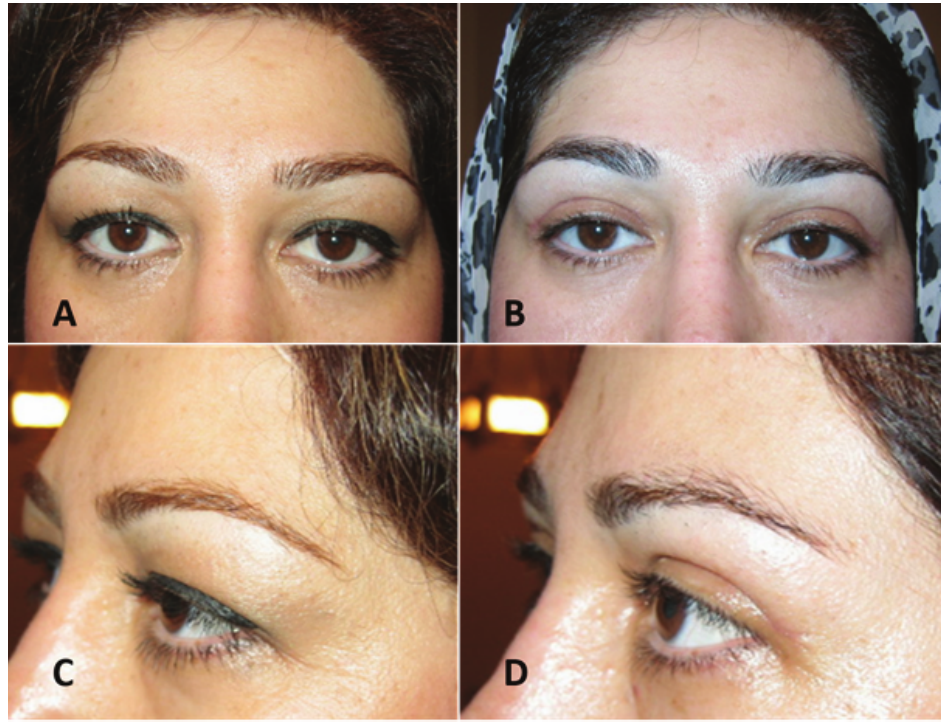
Figure 3. A gentleman before (A & C) and six months after (B & D) upper blepharoplasty and internal browpexy. Internal browpexy has resulted in no or minimal change in the eyebrow